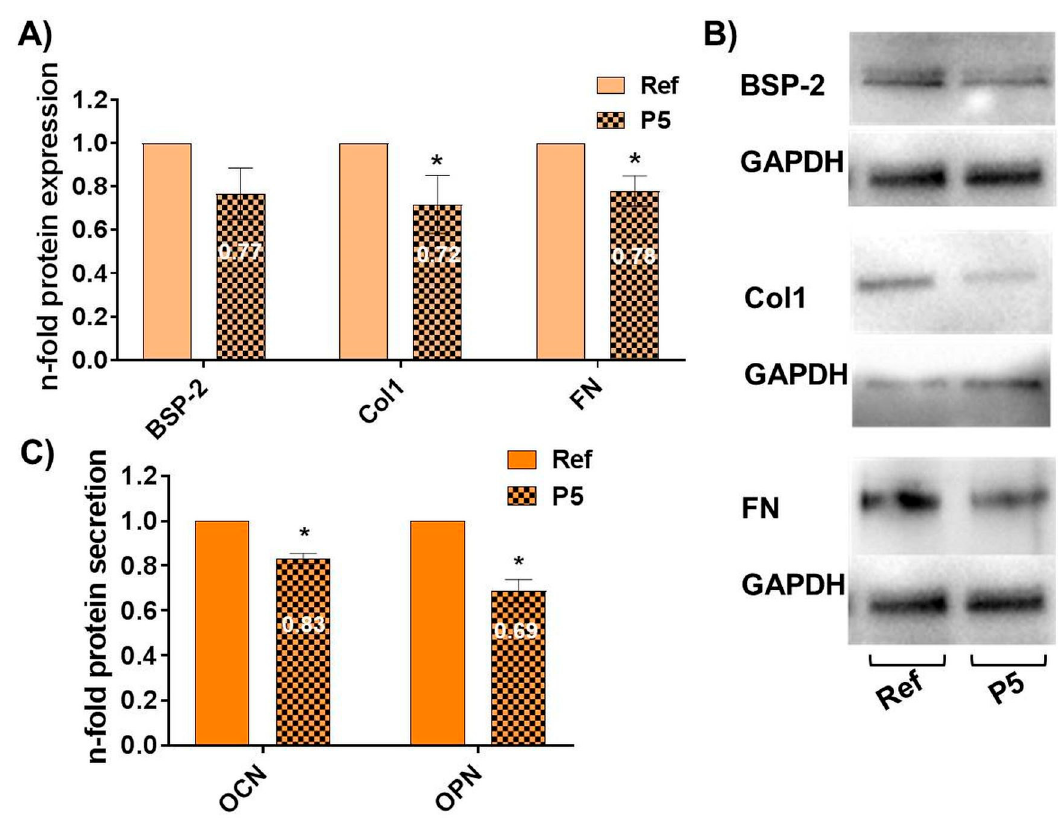
Figure 5. Quantification of the osteoblastic markers bone sialo protein-2 (BSP-2), collagen type I (Col1), fibronectin (FN), osteocalcin (OCN) and osteopontin (OPN) in MG-63s grown on micro-pillars (P5) or unstructured reference (Ref) for 96 h. ( A ) Immunoblotting and protein expression detection of BSP-2, Col1 and FN. (Ref values normalized to 1; mean ± s.e.m., 4 independent experiments; Mann-Whitney U test; * p < 0.05) ( B ) Representative Western blot bands of BSP-2 (59 kDa), Col1 (200 kDa), FN (220 kDa) and the loading control GAPDH (glyceralaldehyde 3-phosphate dehydrogenase; 37 kDa) in MG-63s on P5 compared to Ref (one out of four experiments). ( C ) Relative protein secretion of OCN and OPN by luminex assay, (Ref values normalized to 1; mean ± s.e.m., 4 independent experiments; Mann-Whitney U test, * p < 0.05). Osteoblast marker protein expression and secretion was impaired on micro-pillars after 96 h.